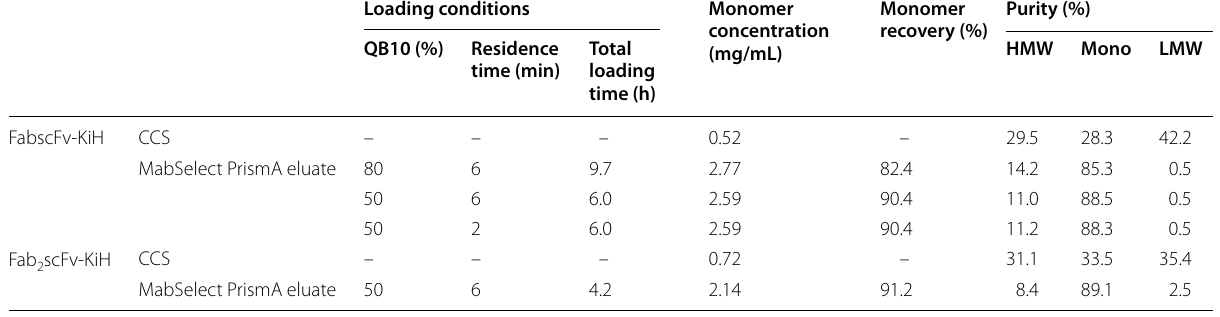
Table 2 Effect of different loading amounts and residence time on the purity profile and recovery of post-Protein A eluates obtained with pH 3.6 elution